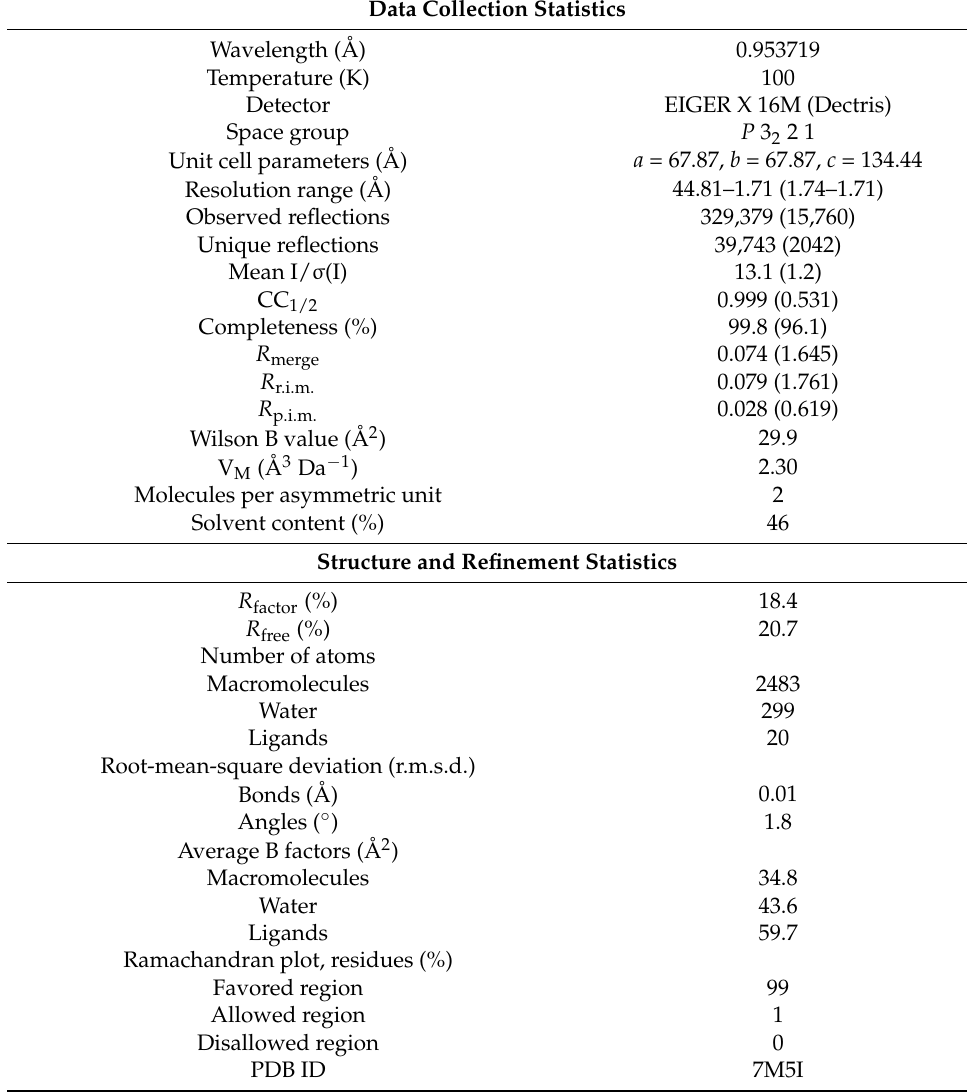
Table 1. X-ray data collection and refinement statistics of LysF1. Statistical values of the highest resolution shell are given in